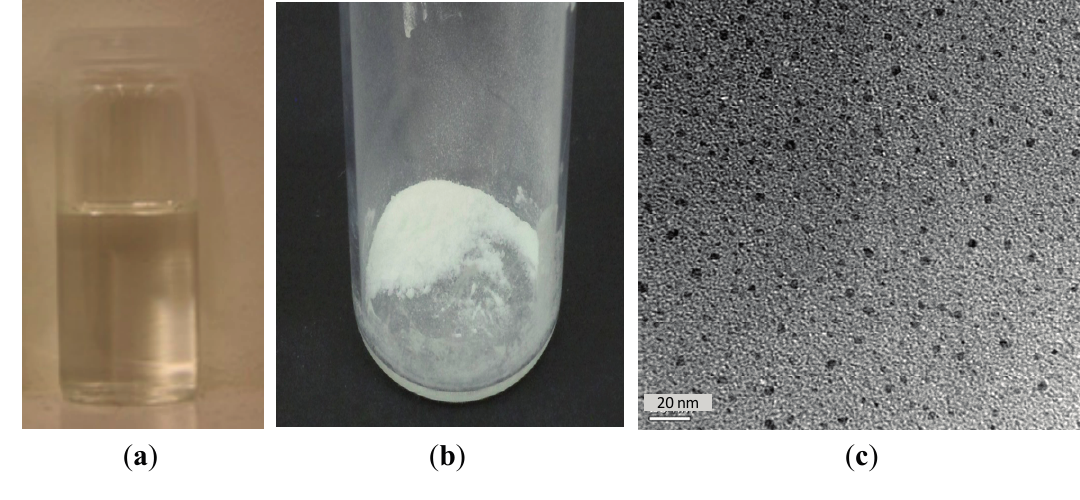
sol and ( b ) TiO nanoparticles after drying and ( c ) TEM 2 2 2